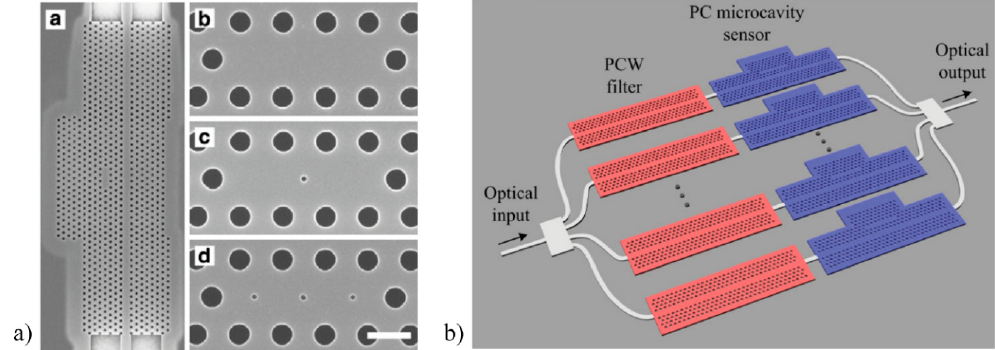
Figure 8. Advances in PCs biosensors. ( a ) Multiple hole defects (MHDs) [88], with permission of the Optical Society of America; ( b ) Transmission bandpass combined with PC sensor, with permission of the AIP Publishing LLC [90].